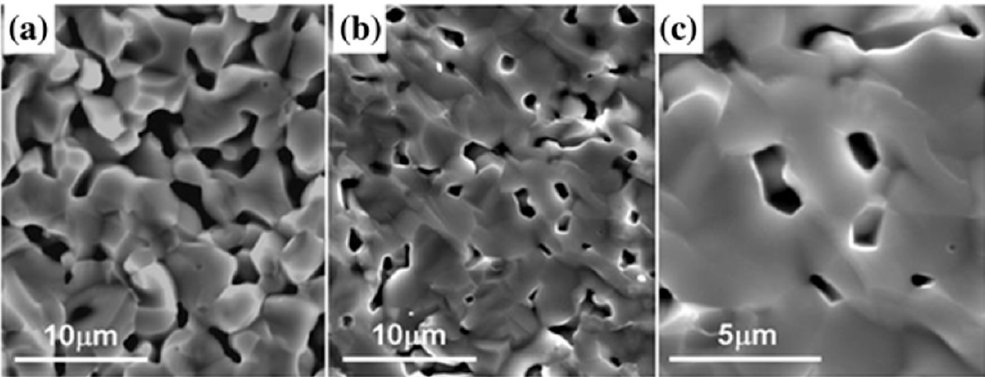
Figure 8. SEM images of Nb − SrTiO 3 ceramics ( a ) with and ( b , c ) without the surface modification of nanosized titania. © 2016 Li E, Wang N, He H, Chen H. Published in [110] under CC BY 4.0 license. Available from: https: // doi.org / 10.1186 / s11671-016-1407-8.